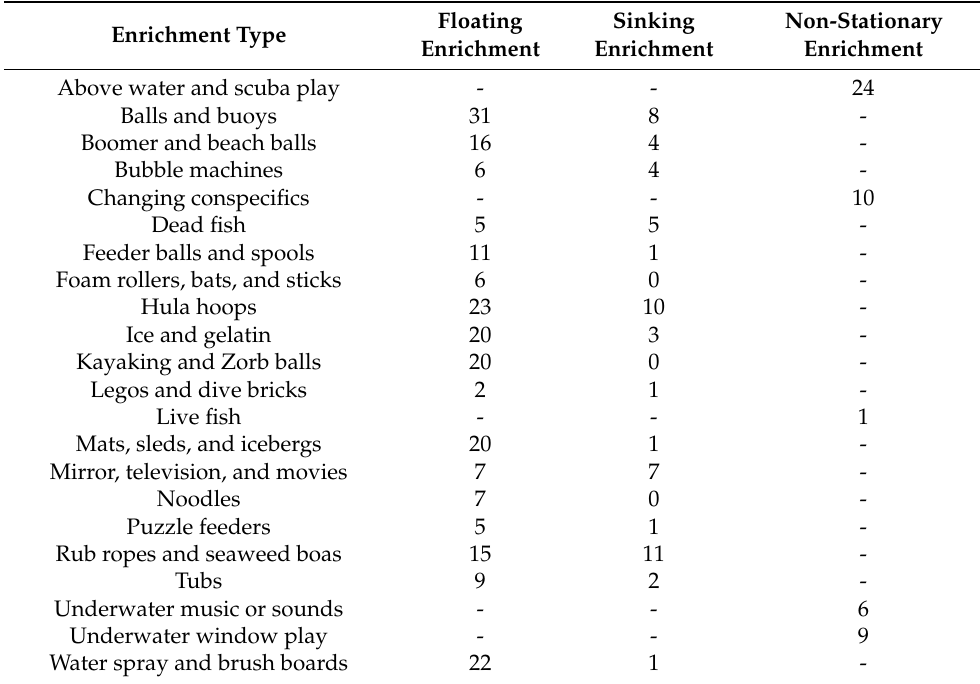
Table 2. Number of habitats that provided each type of enrichment categorized as floating, sinking, and